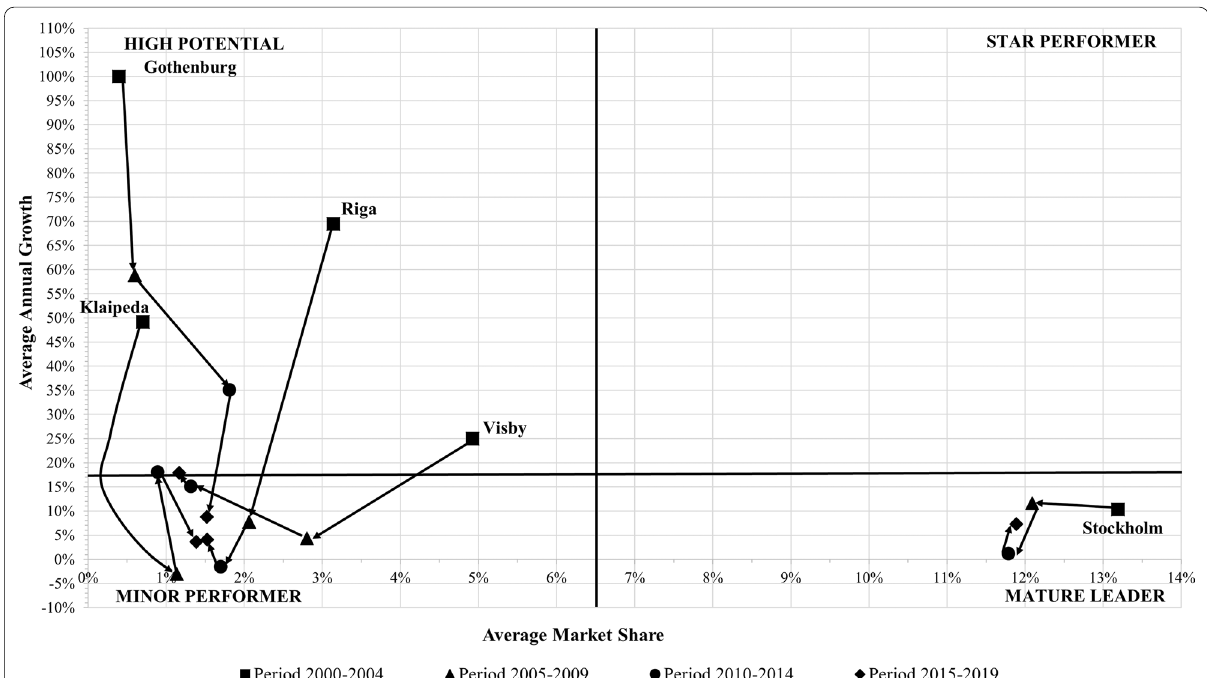
Fig. 7 Dynamic portfolio analysis of ports of Gothenburg, Klaipeda, Riga, Stockholm and Visby during the 2000–2019 period. Source : Author’s